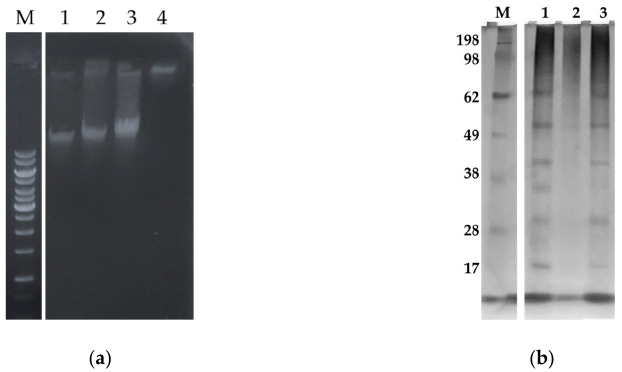
Figure 7. Sarconesin II effects on E. coli DNA and proteins assays. ( a ) Gel retardation assay for evaluating sarconesin II effect on DNA. M, GeneRuler 1kb DNA ladder; 1–3, Sarconesin II concentrations were 0, 25,